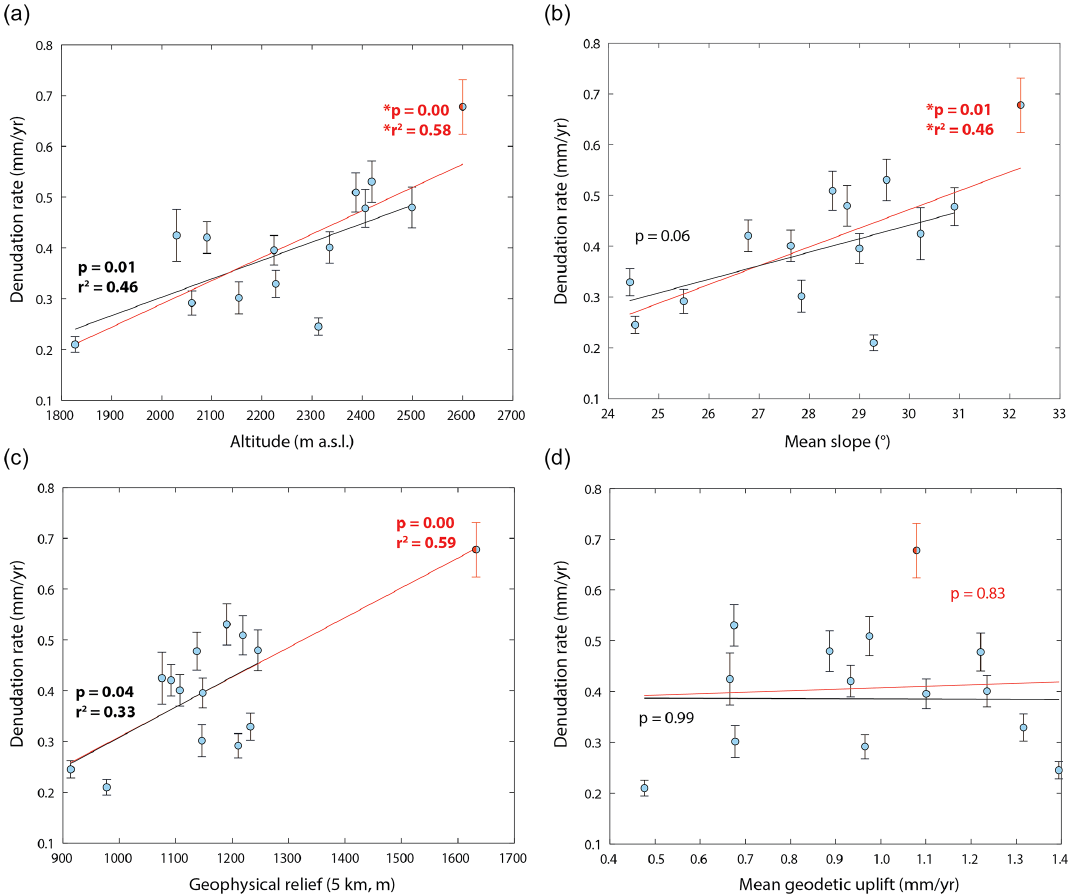
Figure 4. Relationships between tributary–catchment denudation rates and mean catchment (a) elevation, (b) slope, (c) 5km geophysical relief and (d) geodetic uplift. Linear correlations have been calculated including or not sample DB01 (red and black lines, respectively; see main text for discussion). Correlation coefficients ( p value and r 2 ) are reported for each linear regression with statistical significance ( p value < 0 . 05). r 2 is not reported for non-significant correlations ( p value > 0 . 05). Asterisks indicate linear correlations for which DB01 has been considered as an outlier (based on Cook’s distance, Table